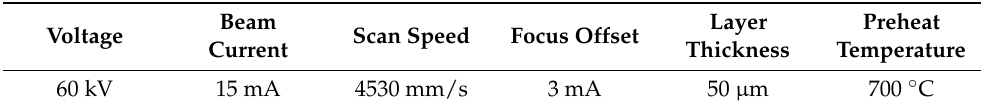
Table 1. Electron beam melting process parameters for Ti-6Al-4V